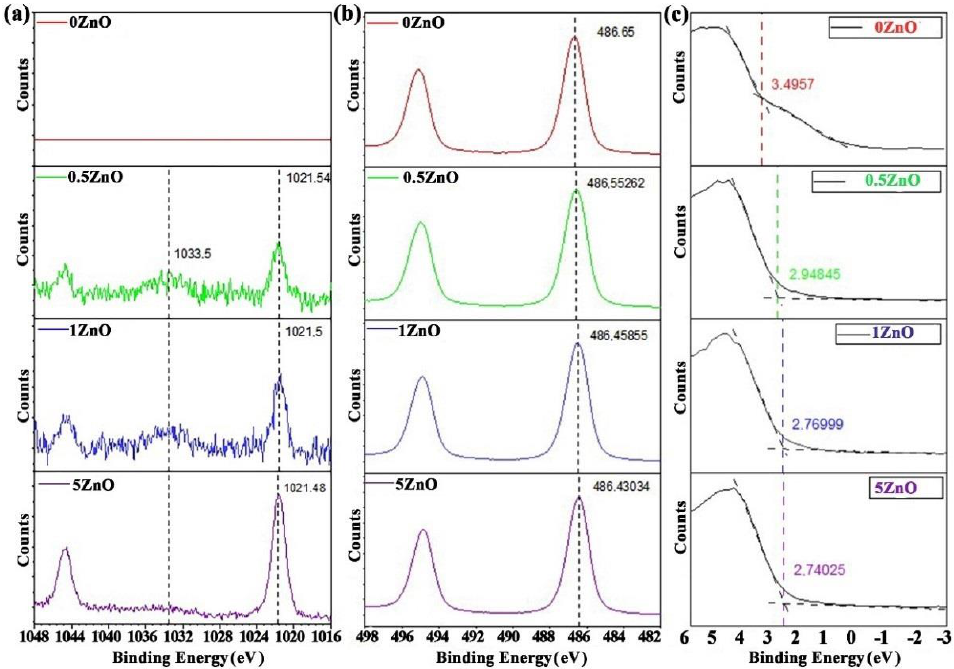
Figure 7. High-resolution XPS spectra of Zn2p ( a ), Sn3d ( b ), and the maximum valence band ( c ) in ZnO-SnO 2 films. Table 2. The surface composition of ZnO-SnO 2 films.